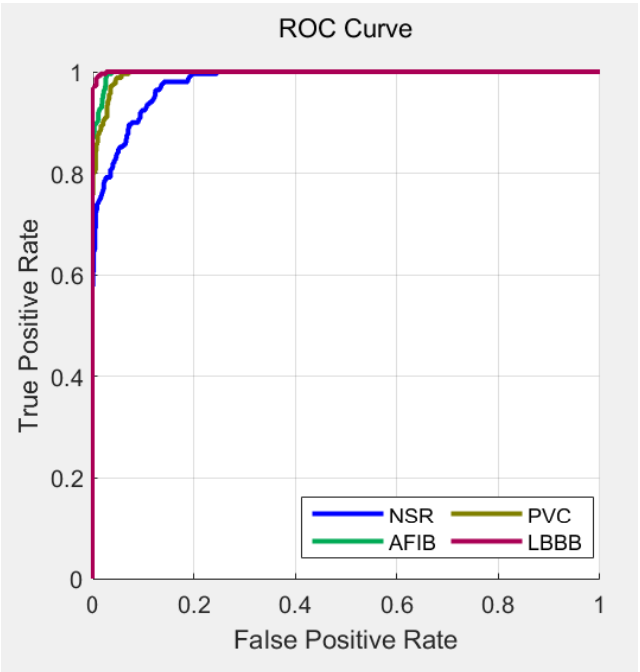
Figure 11. Arrhythmia detection results. A larger AUC corresponds to better performance. AUC denotes the area under the graph, and the four graphs represent the AUC that is proportional to the accuracy of each class.